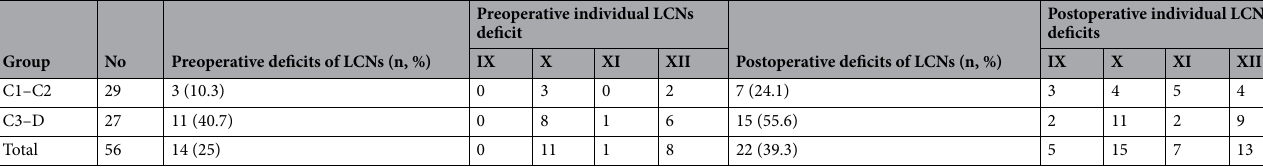
Table 3. Preoperative and postoperative LCNs deficit (n = 56). LCNs lower cranial